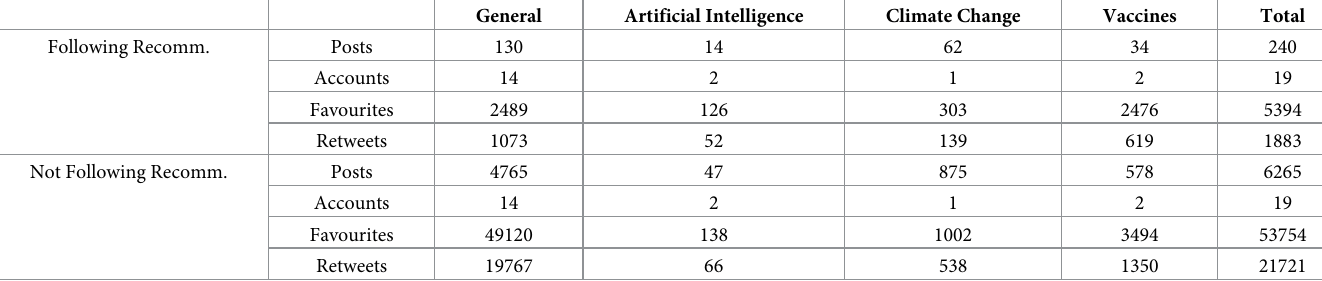
Table 2. Twitter. Count of posts, accounts and reactions to Twitter posts categorised by their compliance with the introduced recommendations. Following Recomm.